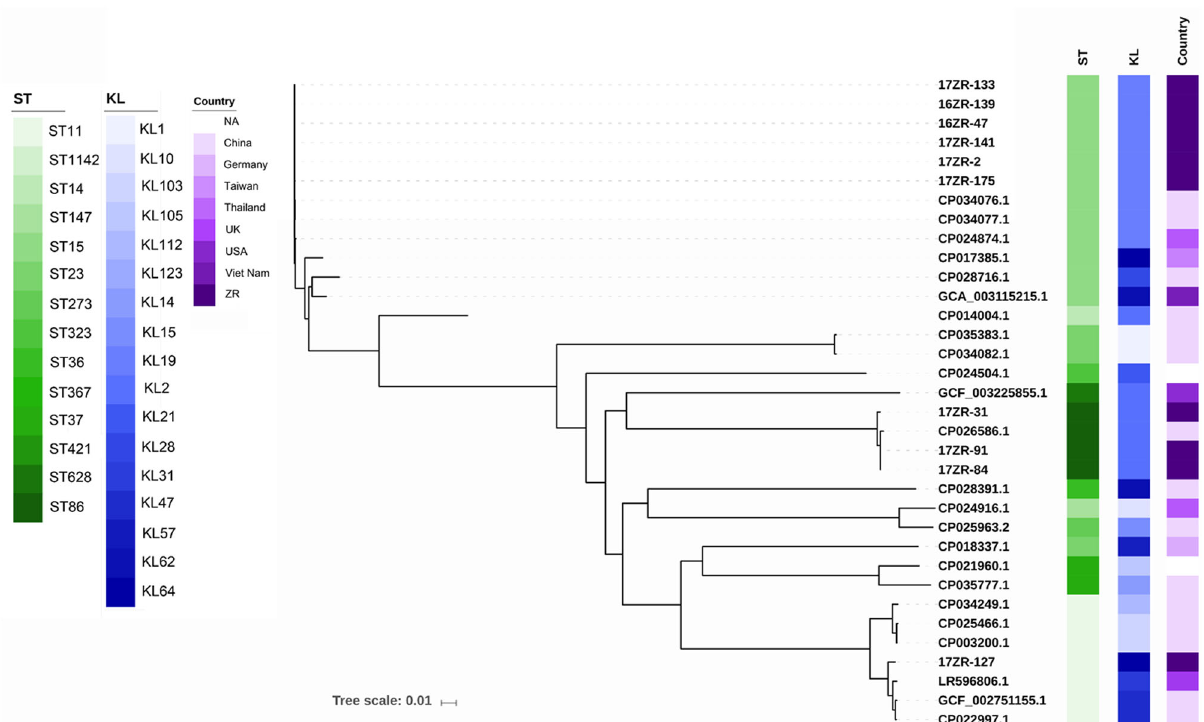
Fig. 4 Phylogenetic analysis of bacterial strains carrying p17ZR-91-KPC like plasmids. Strains with ZR in strain ID indicated that these CRKP strains were recovered from the same hospital in China as that of strain 17ZR-91; genomes of other strains, which were recovered from different countries, were retrieved from GenBank. Strains belonging to other genus such as E. coli were not included in phylogenetic